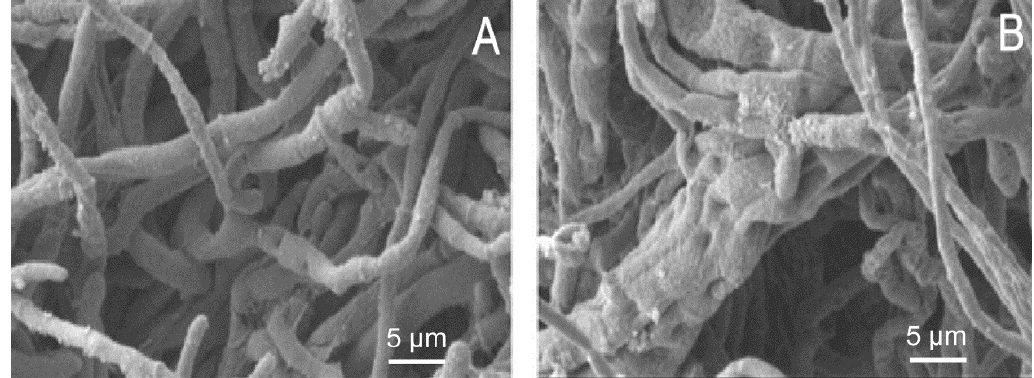
Figure 2. Eucalyptus oil effects on M. grisea hypha growth by the scanning electron microscopy. ( A ) control group; ( B ) experimental group.